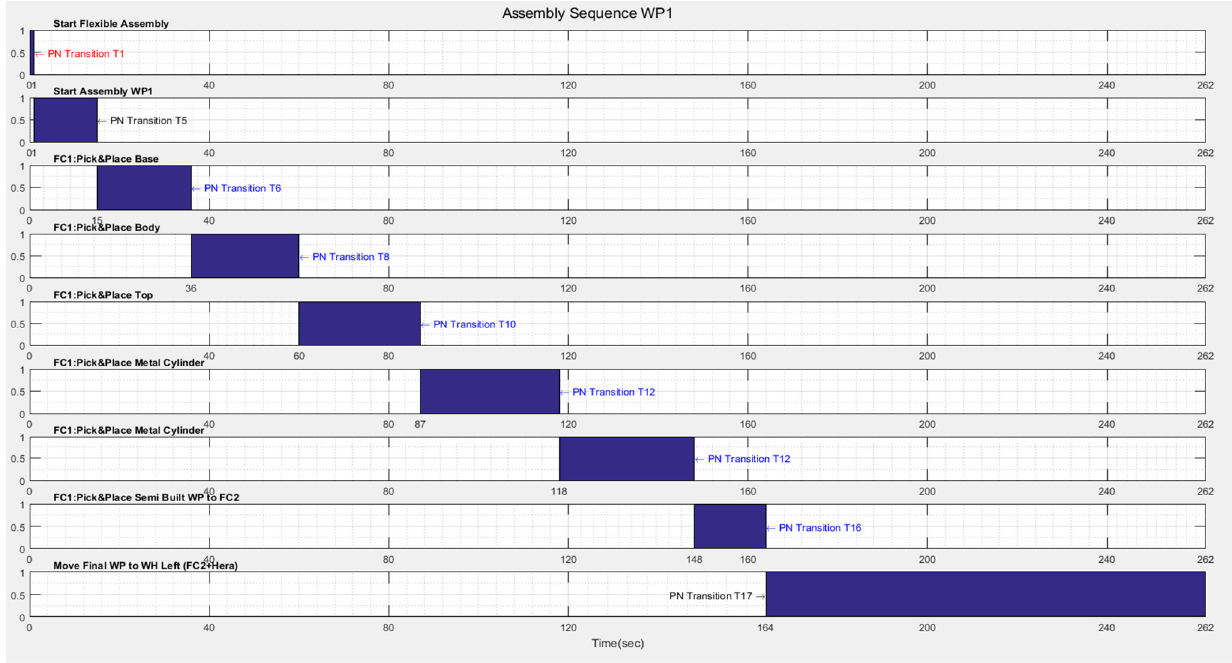
Figure 25. Results for continuous and discrete places associated with displacements of FC with IRM for Assembly WP1.